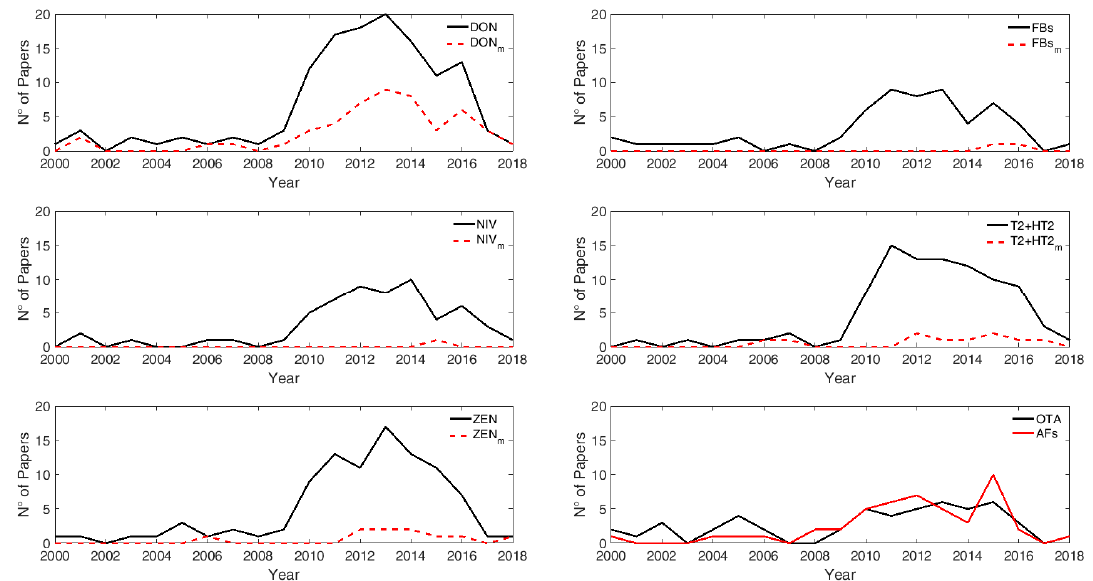
Figure 5. Distribution of records according to year of publication. Solid lines refer to parent mycotoxins